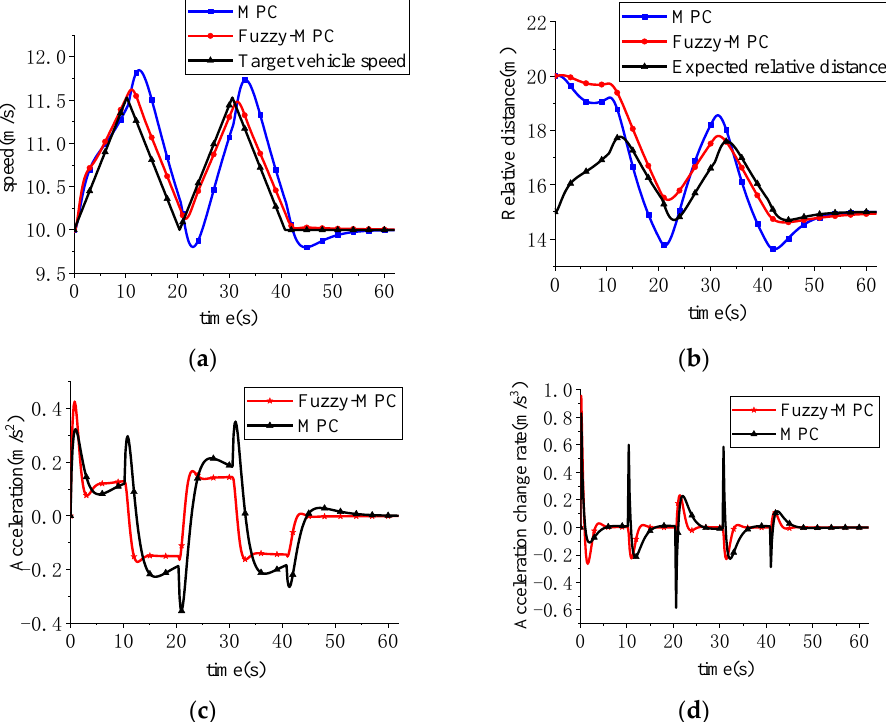
Figure 3. Stable follow: ( a ) speed; ( b ) relative distance; ( c ) acceleration; ( d ) acceleration change rate.